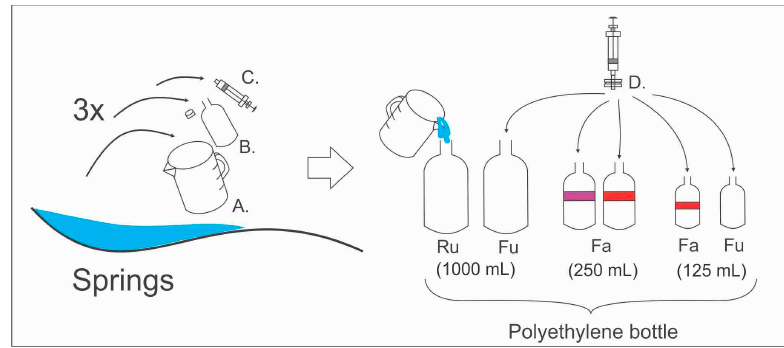
Figure 5. Overview of the collection of a sample from springs for chemical analysis. The equipment from the picture is a ( A ) bucket, ( B ) sample bottle, ( C ) syringe and ( D ) filter (0.45 µm). Ru is stands for raw unacidified, and Fu/Fa is filtered unacidified/acidified. The sample with a purple label is a sample that was preserved using H 2 SO 4 , while that with a red label was preserved using HNO 3 .